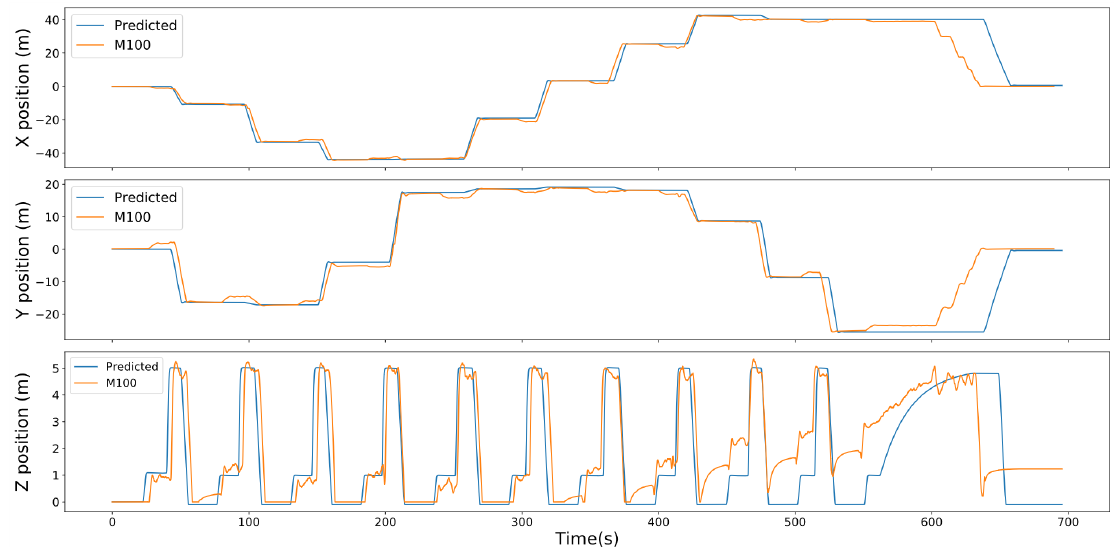
Figure 7. Trajectory of the the M100 compared against the desired trajectory in the x , y and z